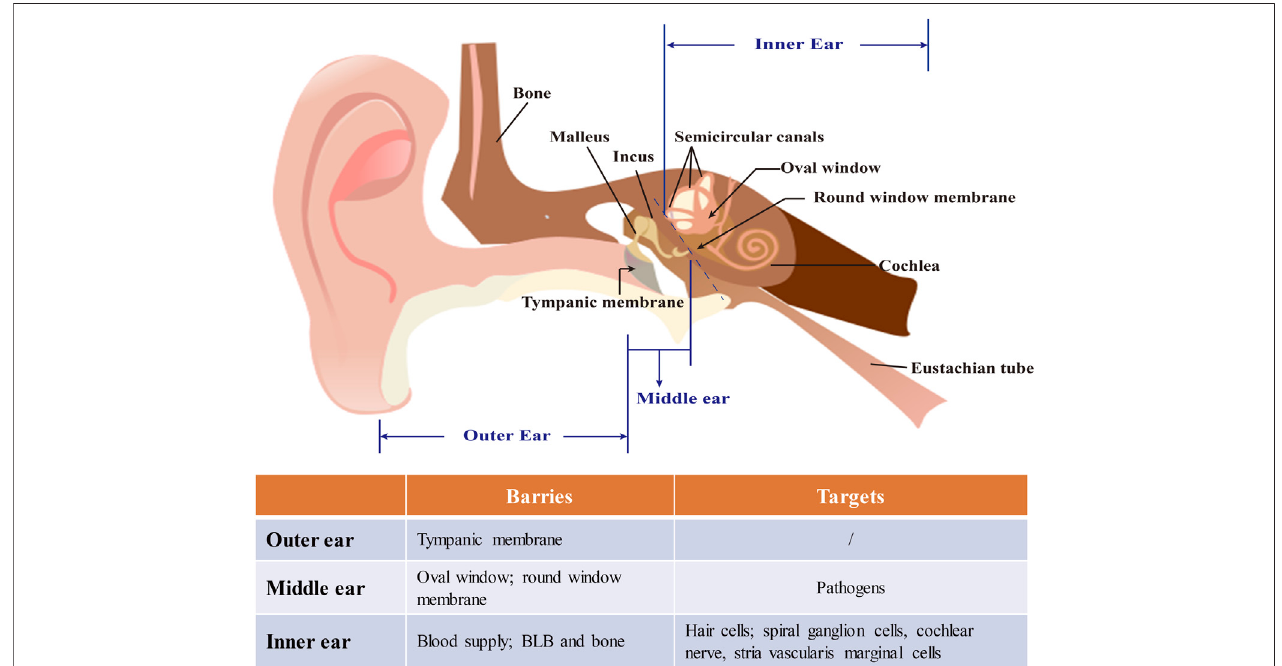
FIGURE 2 | The structure of the ear and barriers and targets in nanomedicine-based treatment of inner ear diseases. The ear is composed of outer, middle, and inner ears. The tympanic membrane which separates the outer from the middle ear anatomically is a major barrier for drug delivery and can be bypassed by minimally invasiveapproacheslikeanintratympanicinjection.Themiddleearfaceoftheroundwindowmembrane(RWM)isthepathwayfornoninvasivenanomedicaldrugdelivery to the inner ear. Nanocarriers are usually locally loaded onto the RWM in gel for a sustained release of drugs. The inner ear is thought rarely to be a target for operations indirect drug delivery because of the risk of infection. Due to the characteristics of inner ear diseases, neurons and hair cells are often the main targets in its nanomedicine-based